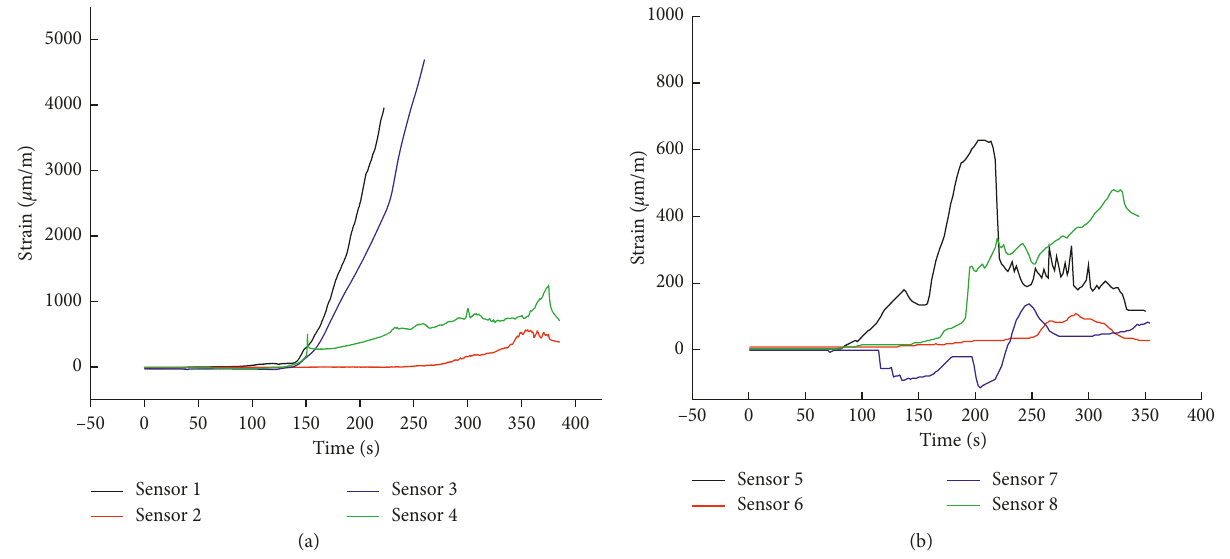
Figure 5: The grating strain-time curve at 20mm from the roadway wall: (a) the strain-time curve of 1–4 FBG sensors and (b) the strain- time curve of 5–8 FBG sensors.